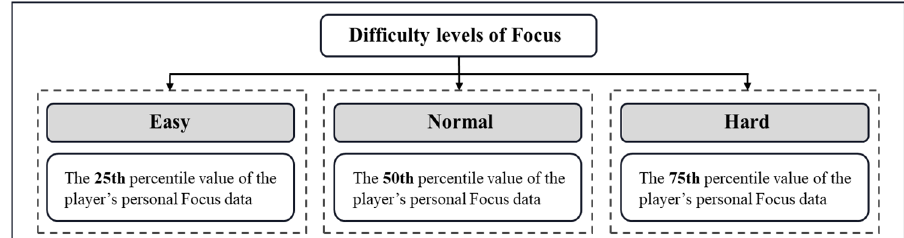
Figure 8. Attention value thresholds for different difficulty levels.